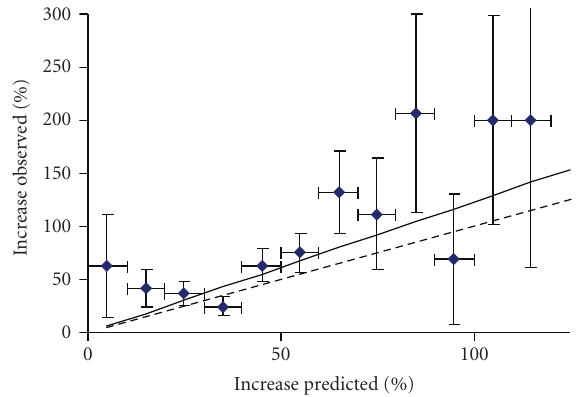
Figure 7: Observed percentage increase in numbers of storms versus the predicted percentage increase during the two halves of the 47-year interval 1960–2006. Each data point groups together all cells across the globe having a predicted increase falling in decadal intervals 0% to 10%, 10% to 20%, and so forth. The data should be consistent with a line through the origin having unit slope shown dotted, whereas the best fit line has a slightly larger